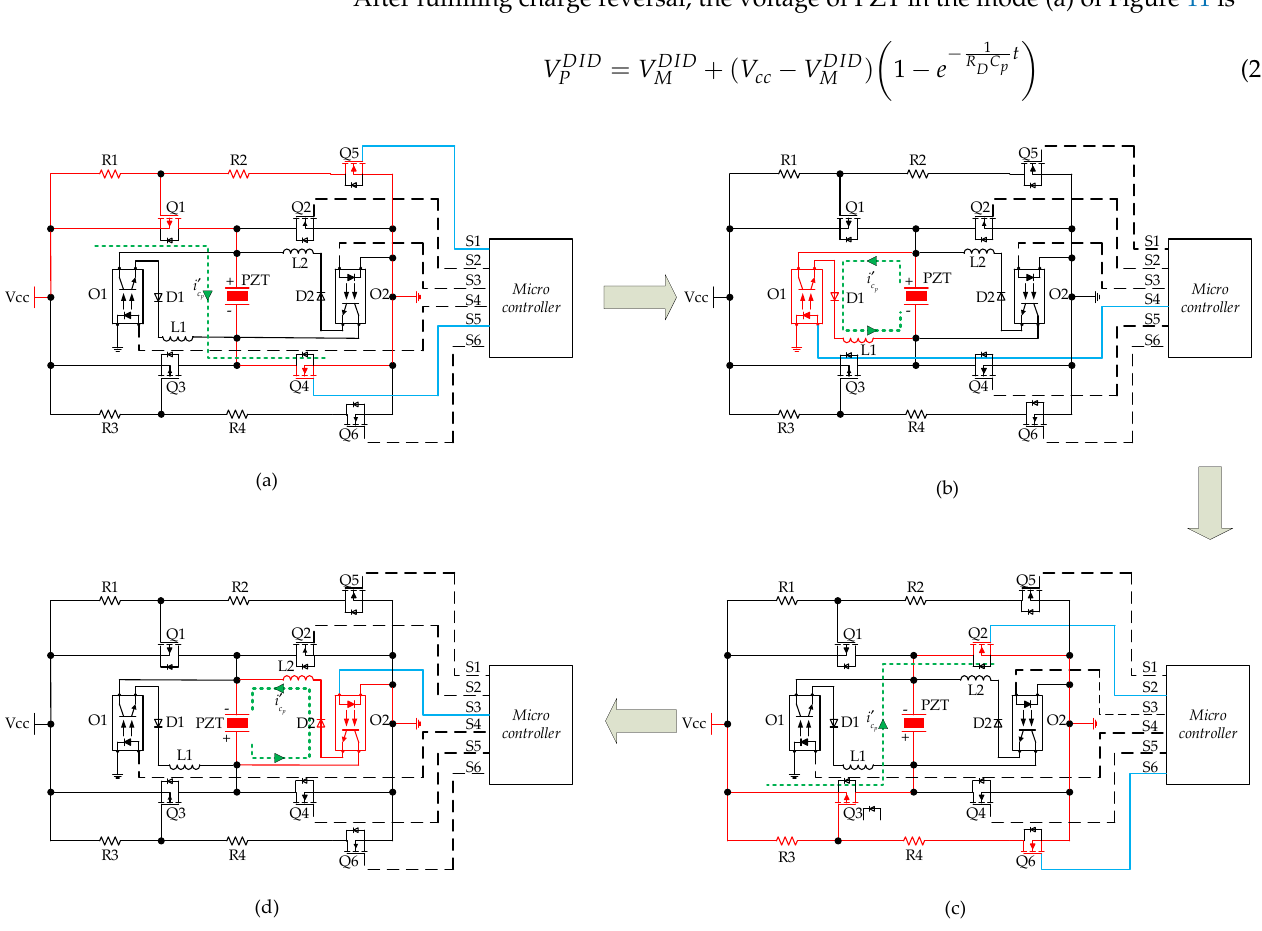
Figure 11. Driving process of the DID circuit, including four stages ( a – d ) in a cycle.